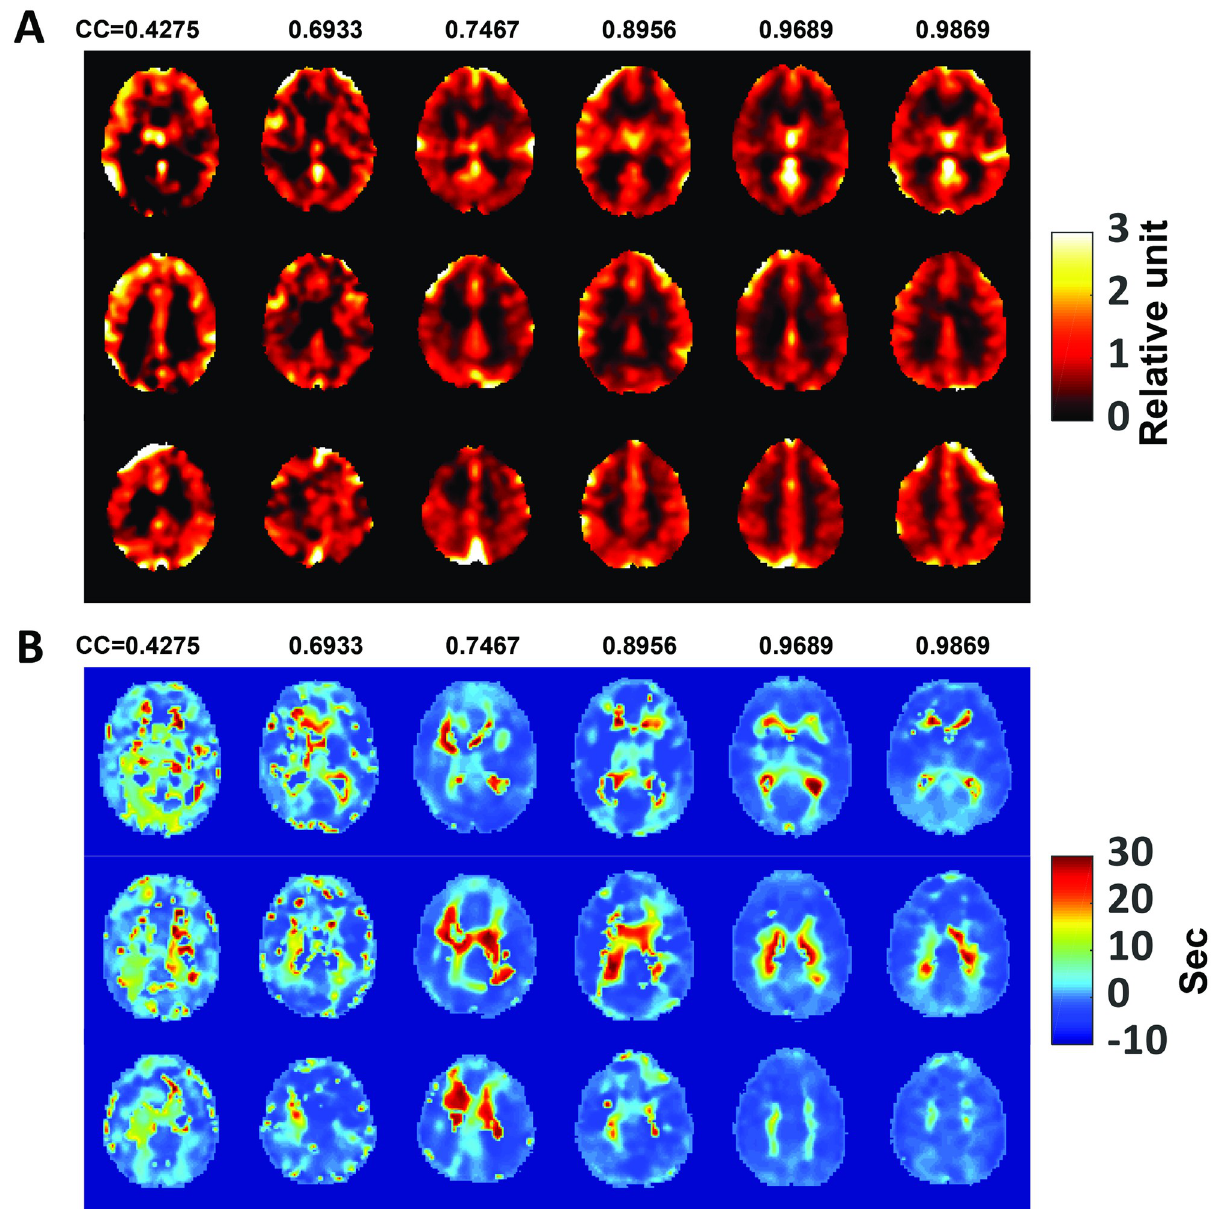
Fig 8. Examples of CO2-CVR results. (A) Relatiev CVR maps in MNI space from the same 6 subjects shown in Fig 7. (B) Time-shift maps from the same subjects.